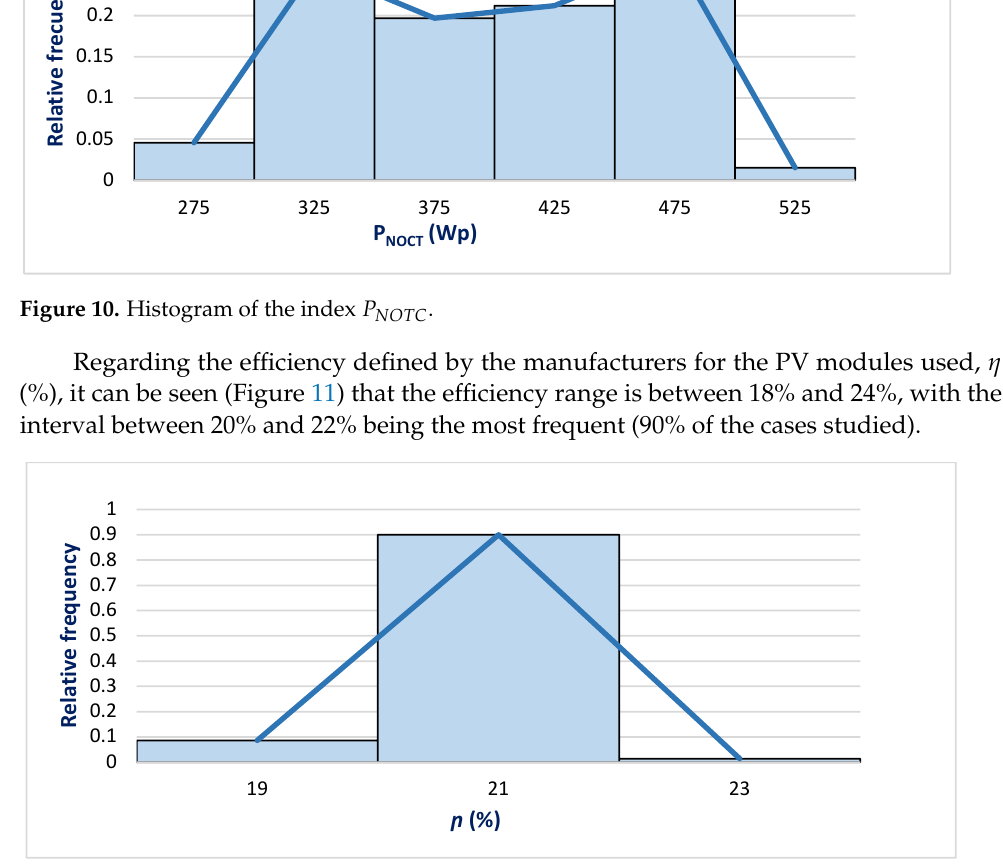
0 ꞃ (%) . Figure 11. Histogram of the index Figure 11. Histogram of the index η 𝜂𝜂 For the characterization of the inverters, the (kVA) index is defined, which rep- resents the nominal power installed in the inverters of each PV plant. The results obtained 𝑃𝑃 𝐼𝐼𝑃𝑃𝐼𝐼 for this indicator show great variability (Figure 12), which is because the indicator de- pends on the design strategies, establishing an inversely proportional relationship be- tween the number of inverters and their installed power. The results show that the nomi- nal power range of the inverters is between 100 and 4800 kVA. However, it is verified that the most frequent classes for 𝑃𝑃 𝐼𝐼𝑃𝑃𝐼𝐼 are 0–500 kVA, 1500–1750 kVA and 3500–3750 kVA, with 41.66%, 13.33% and 11.66% of the cases, respectively. For the rest of the indicator values, the relative frequency does not exceed 10% in any case. Figure 12. Histogram of the index 𝑃𝑃 𝐼𝐼𝑃𝑃𝐼𝐼 . Continuing with the characterization of the inverters, the 𝑁𝑁 𝑆𝑆 indicator represents the number of strings per inverter. Once again, its histogram shows a high dispersion (Figure 13) attributed to the dependence of this indicator on the strategy used to define the num- ber of inverters in the installation. Despite this, it is found that the most common config- uration has less than 20 strings per inverter, with a relative frequency of 27.14%. This rel- ative frequency exceeds by more than double the relative frequency of any of the remain- ing classes considered for this indicator.